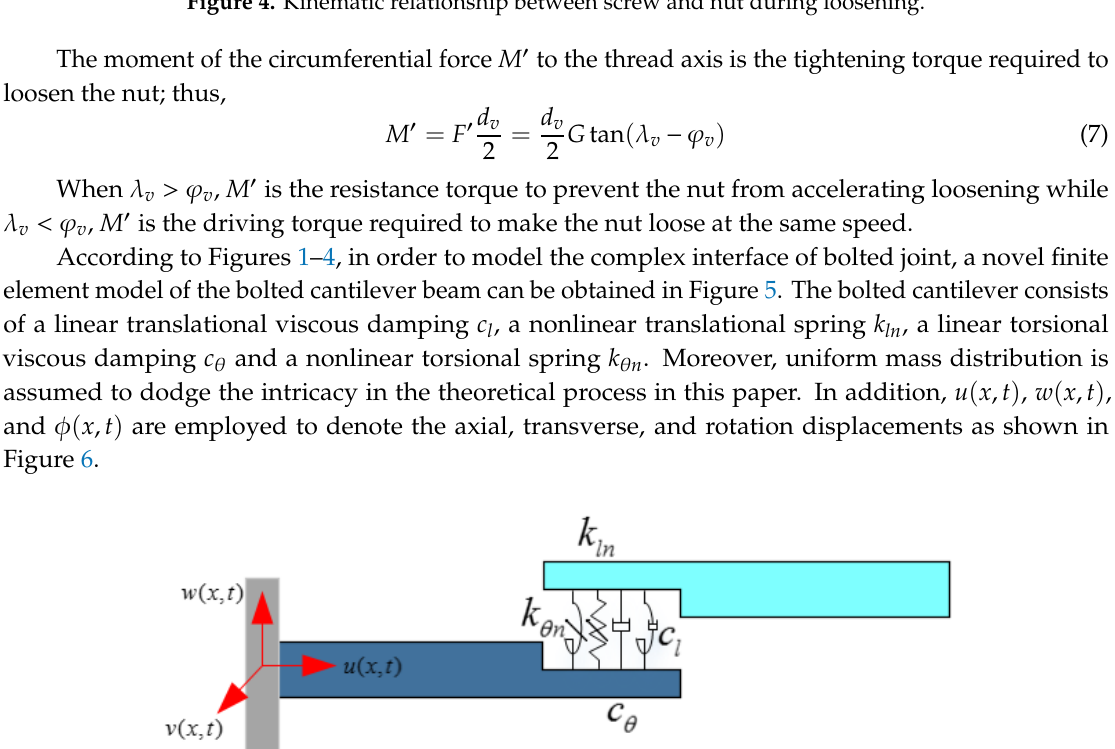
Figure 4. Kinematic relationship between screw and nut during loosening.